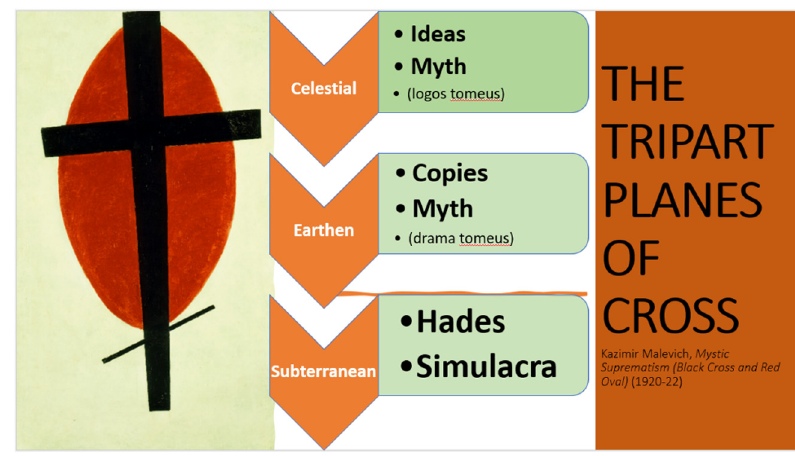
Figure 2: The Platonic